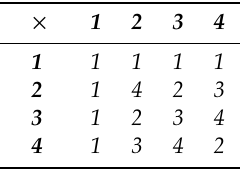
Table 4. The operation × on S